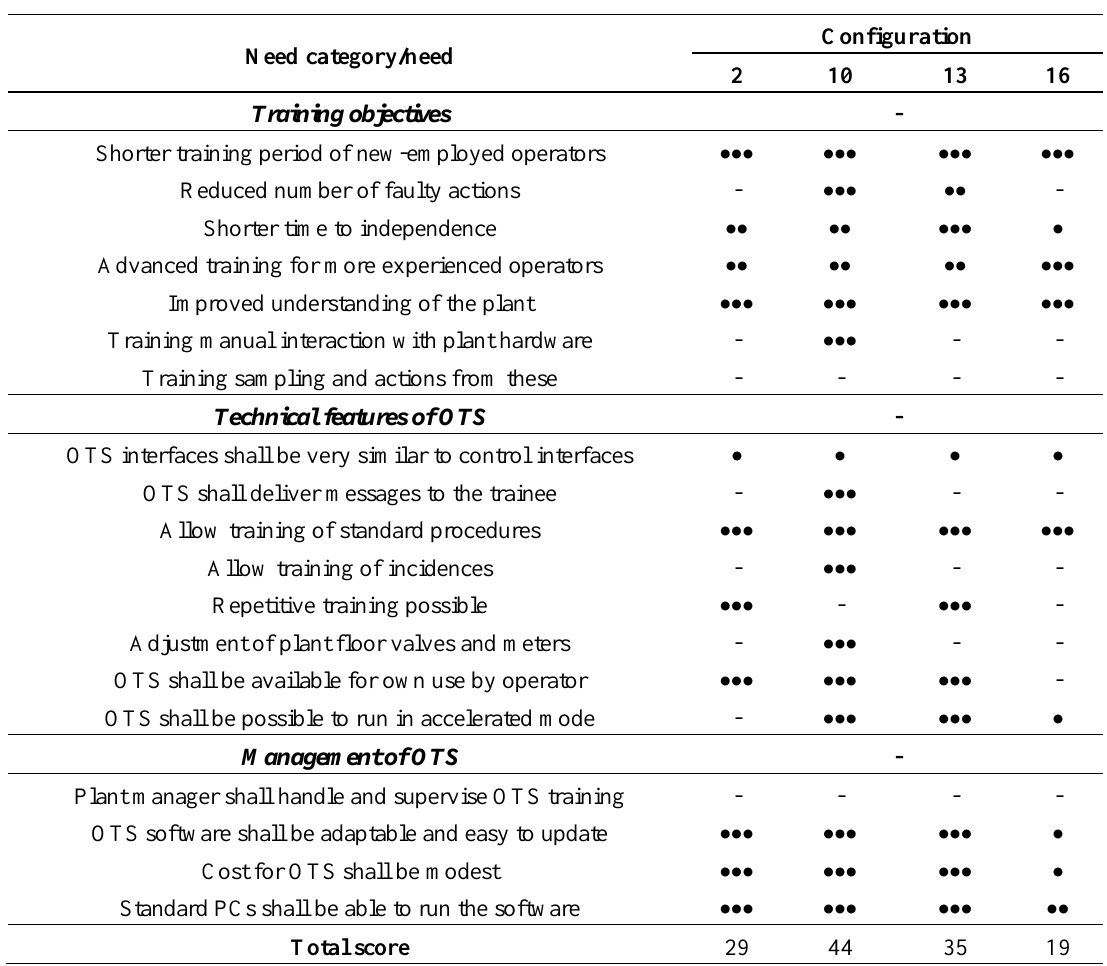
Table 2. Screening configurations versus training